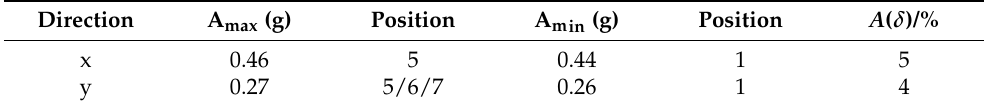
Table 5. Peak acceleration at different positions of the raft foundation.